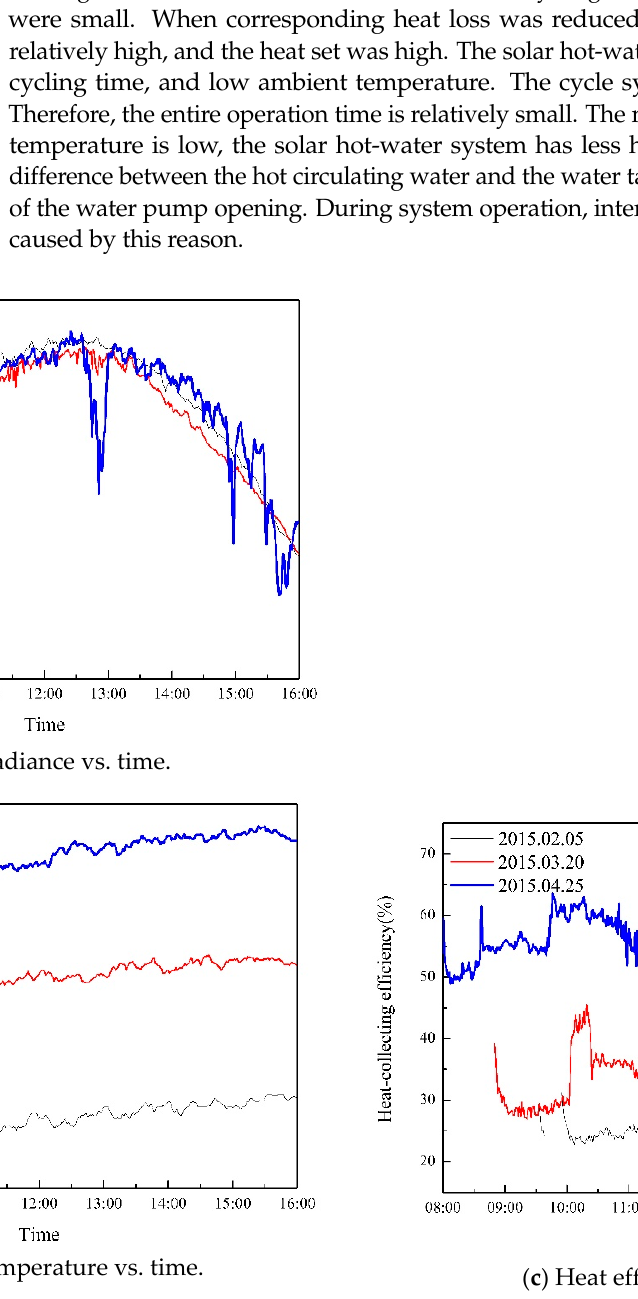
Figure 2. The relationship among solar irradiance, ambient temperatures, and thermal efficiency.